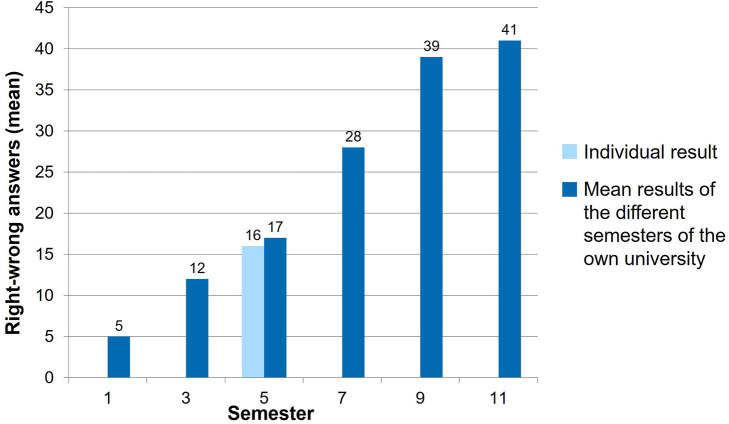
Level of knowledge of each semester, exemplary presentation of a fifth-semester student.